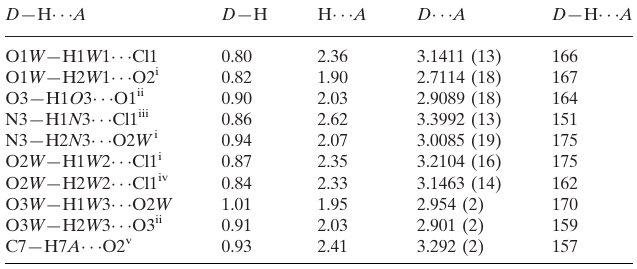
Hydrogen-bond geometry (A ˚ , (cid:3)